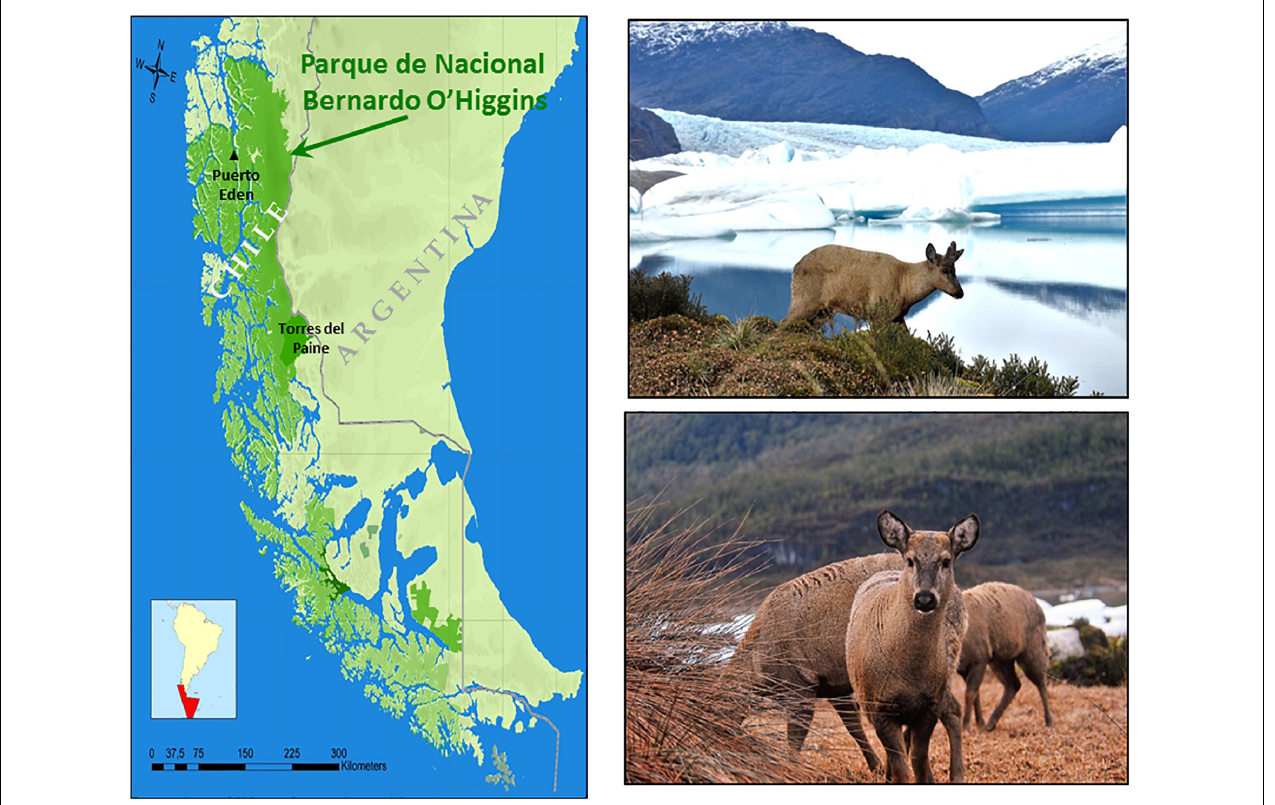
FIGURE 8 | Protected areas along the Patagonian coast in Chile (green) and the locale of its largest national park (Bernardo O’Higgins), its most visited (Torres del Paine), and the fishing village hamlet of Puerto Eden. Huemul male (top) and females (below) on re-vegetated spit with a recessing glacier